Question: What caption would you write for this figure?
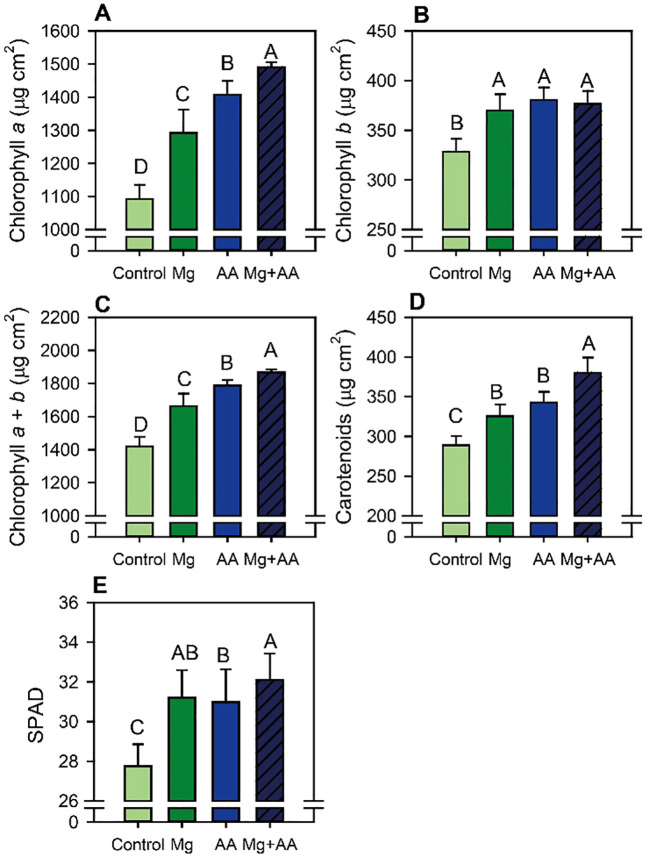
Answer: Contents of (A) chlorophyll a (Chl a ), (B) chlorophyll b (Chl b ), (C) chlorophyll a + b (Chl a + b ), (D) carotenoids and (E) SPAD index in the leaves of maize plants as affected by the foliar application of magnesium (Mg) and/or amino acids (AA). Bars represent means across the 2021 and 2022 off-season growing periods. Different letters indicate significant differences among treatments (LSD, p ≤ 0.05). Error bars represent standard deviation (n = 8).